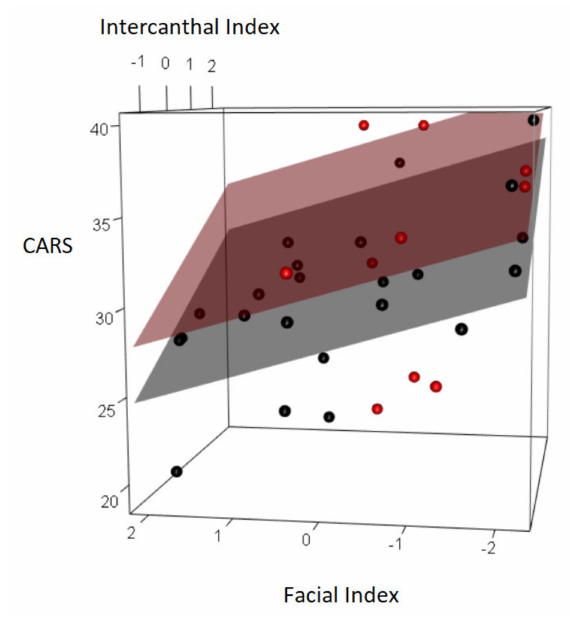
Figure 2. 3D plot representing the coefficients of linear regression analysis on CARS as dependent